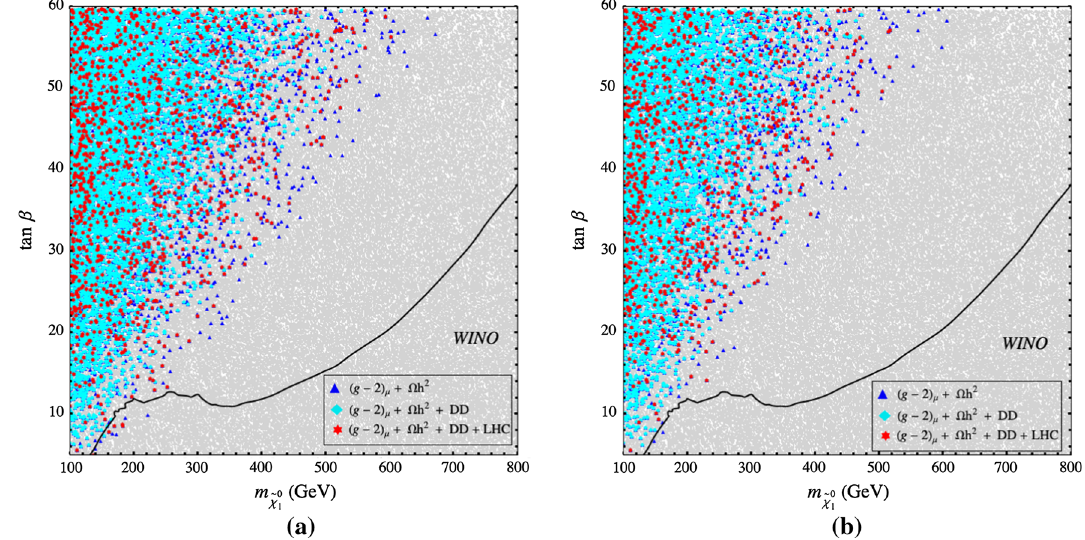
Fig. 10 The results of our parameter scan in the m ˜ χ 0 plane in the wino DM scenario for current (left) and antici- pated future limits (right) from ( g − 2 ) μ . The color coding